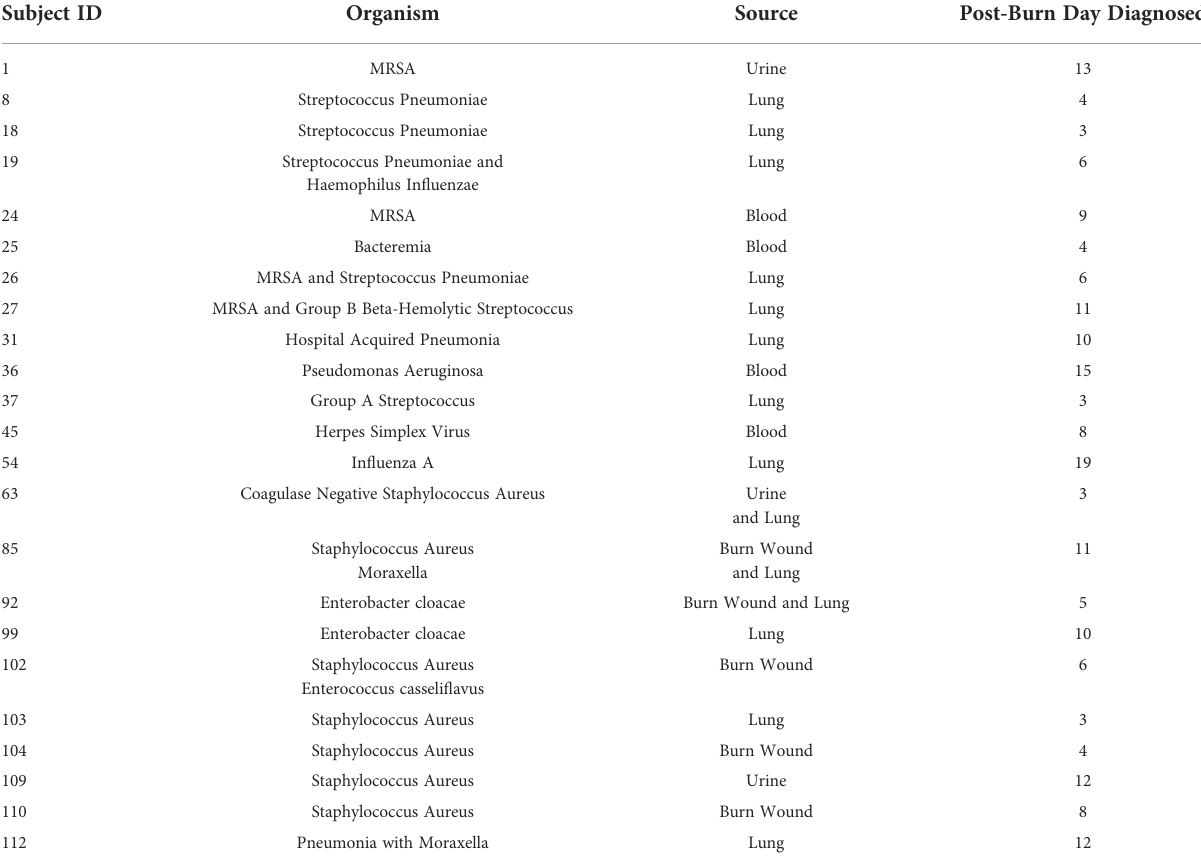
TABLE 2 Infectious